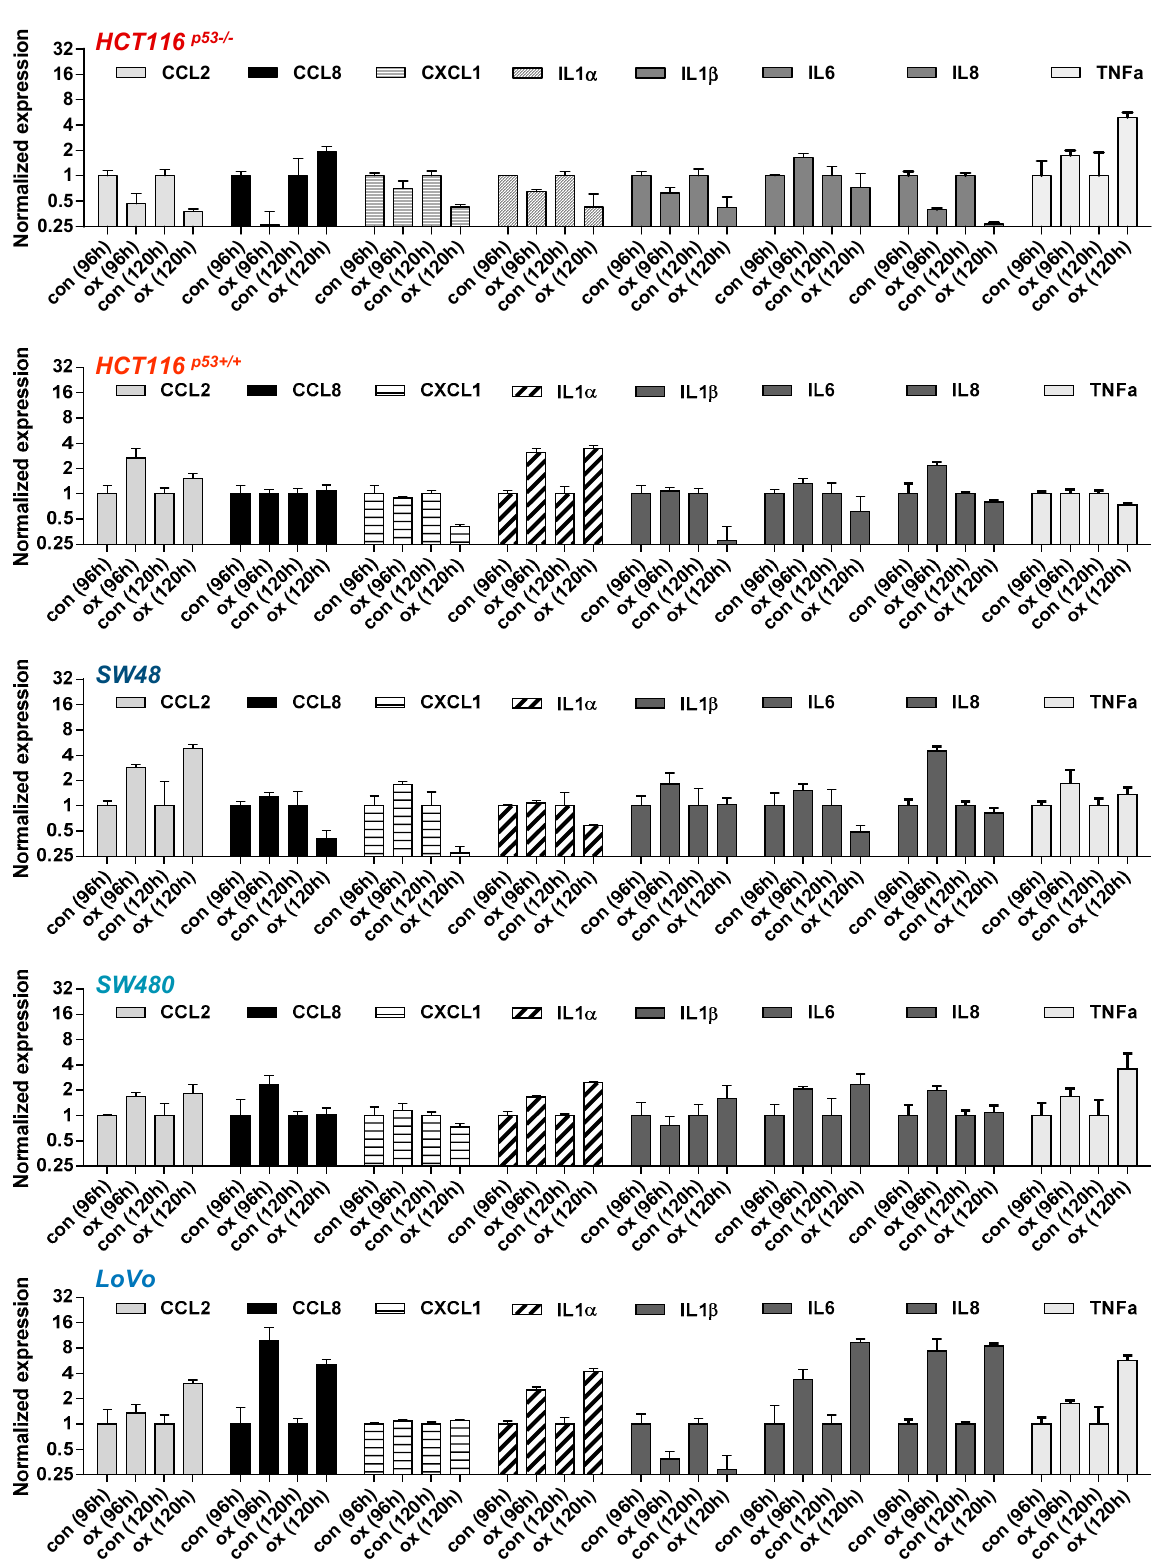
Figure 4. CRC cells were treated with 2.5 µ M oxaliplatin. 96 and 120 h later, expression of the SASP factors CCL2 , CCL8 , CXCL1 , IL1 α , IL1 β , IL6 , IL8 , and TNF α mRNA was measured by qPCR.